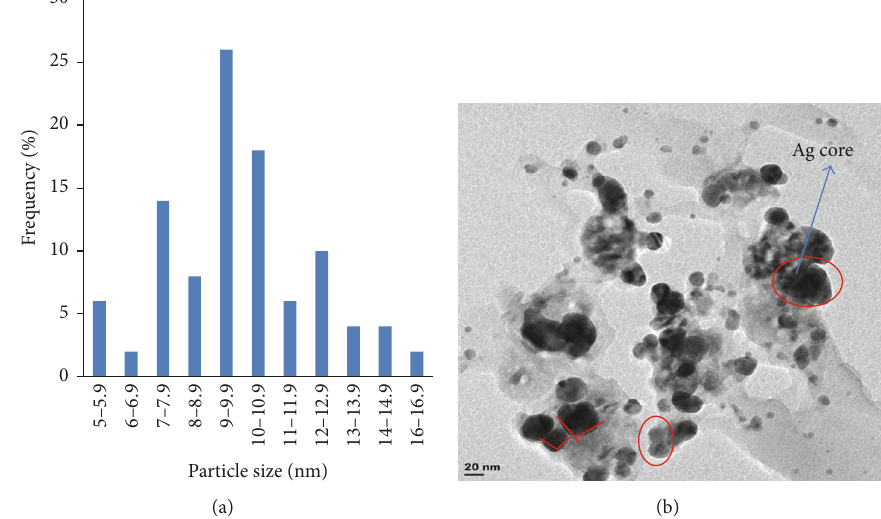
Figure 4: (a) Particle size distribution histogram of Ag/Ni determined from TEM images. (b) Representative TEM image of the bimetallic Ag/Ni NPs under C. indica influenced synthesis.